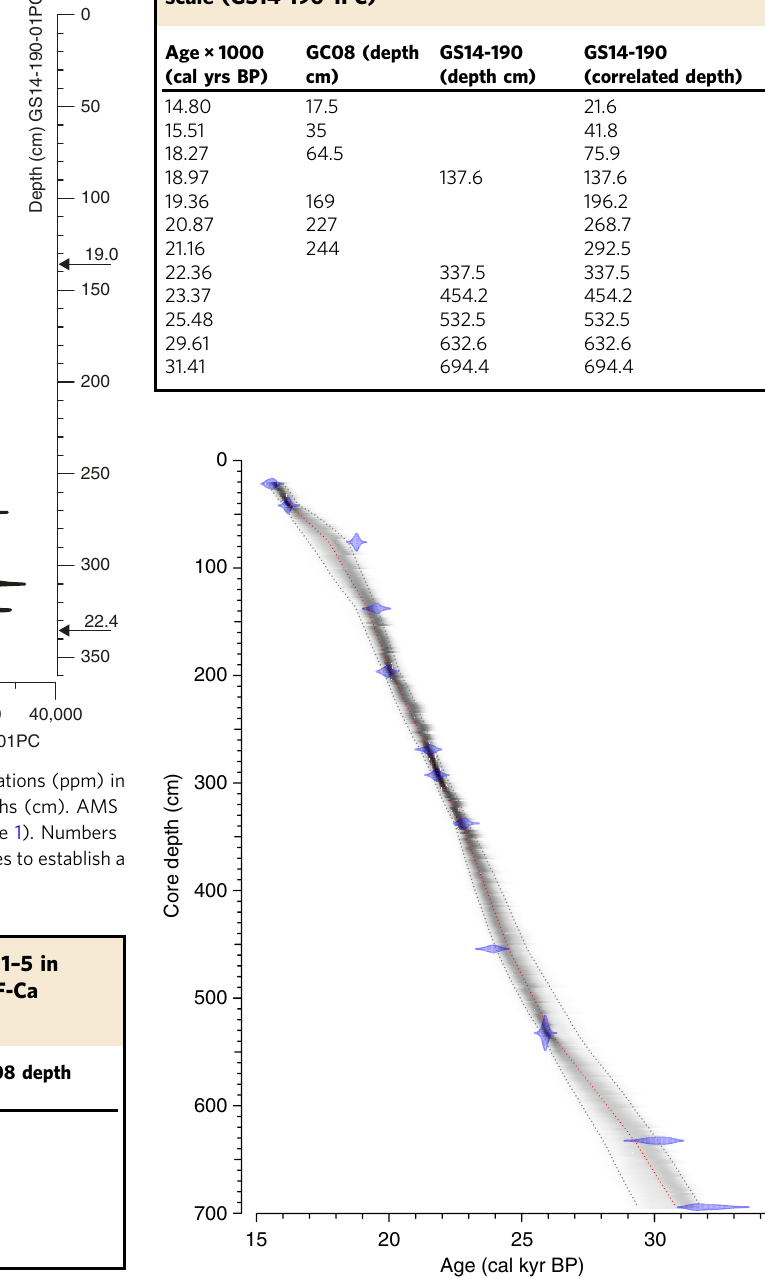
Table 3 Age model based on available AMS 14 C dates in cores 33-GC08 and GS14-190-01PC on one common depth